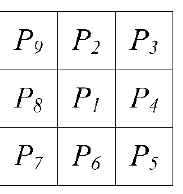
Figure 7. The neighbor pixels set of pixel P 1 .